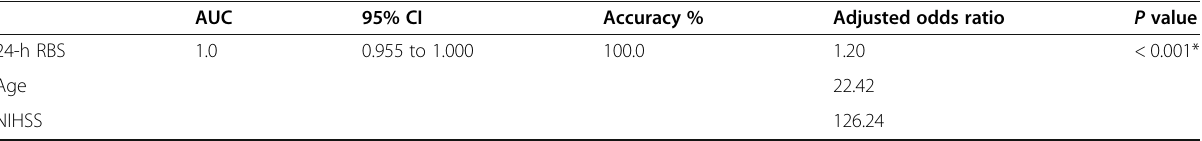
Table 5 Multivariate logistic regression analysis for mortality prediction based on 24-h random blood sugar levels after adjusting for age and